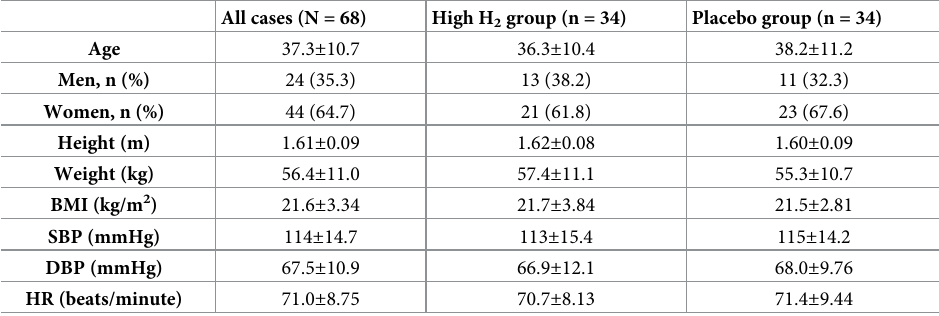
Table 1. Characteristics of the enrolled volunteers.